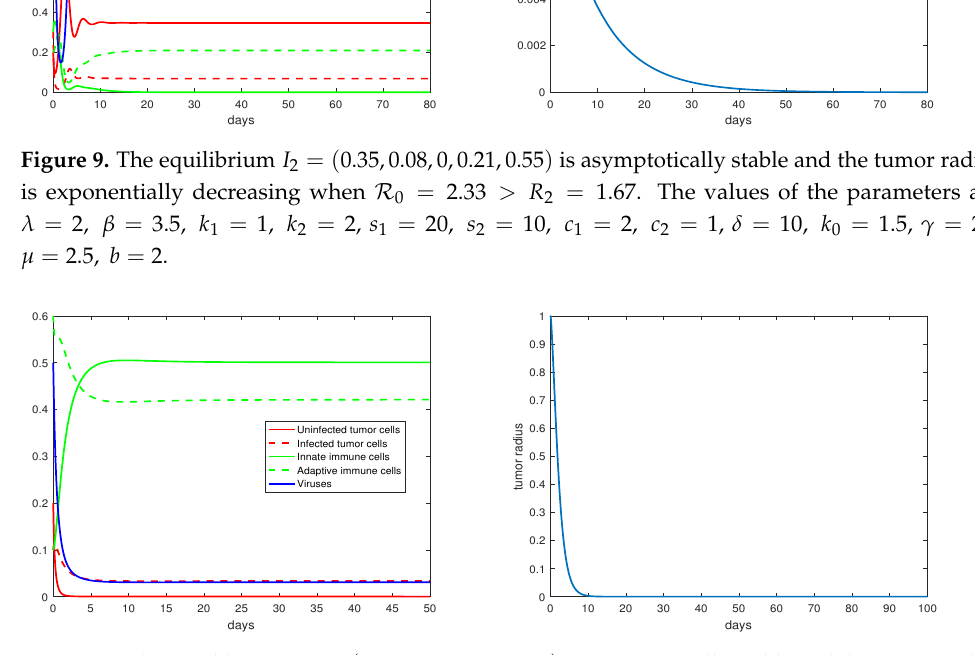
Figure 10. The equilibrium E X = ( 0,0.03,0.5,0.42,0.03 ) is asymptotically stable and the tumor radius is exponentially decreasing when R 0 = 1.2. The values of the parameters are: λ = 2, β = 3.5, k 1 = 1, k 2 = 9.3, s 1 = 30, s 2 = 15, c 1 = 3, c 2 = 2.5, δ = 1.5, k 0 = 1.5, γ = 2.5, µ = 2.5, b = 2.